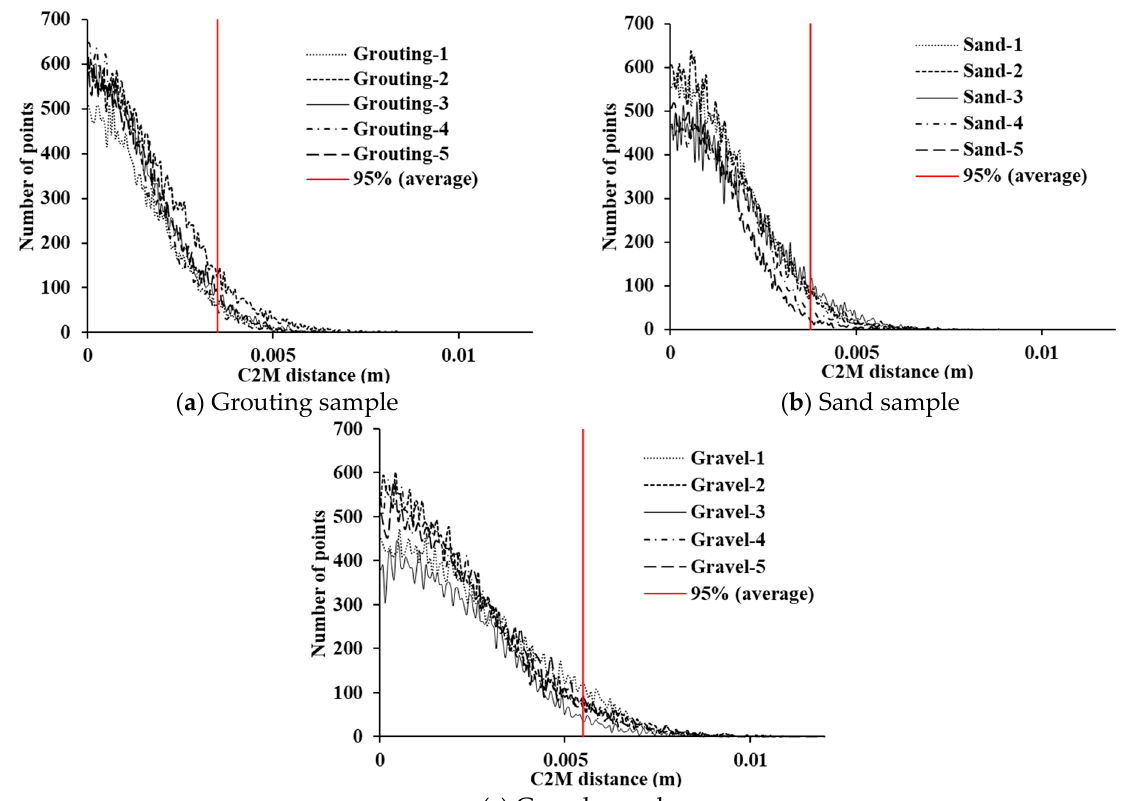
Figure 8. Distance distribution between the fitting plane and point clouds.